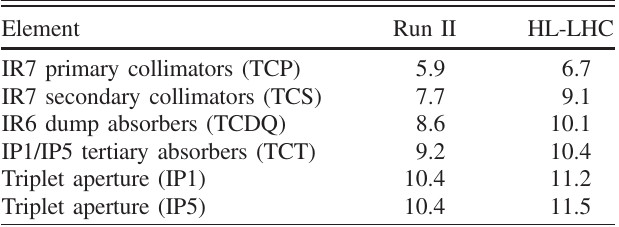
TABLE I. Nominal settings in units of RMS beam size σ of selected collimator gaps in Run II and HLLHCv1.3 optics, assuming a normalized emittance of 2 . 5 μ m · rad, in collision optics [18]. The settings apply equally in horizontal, vertical and skew